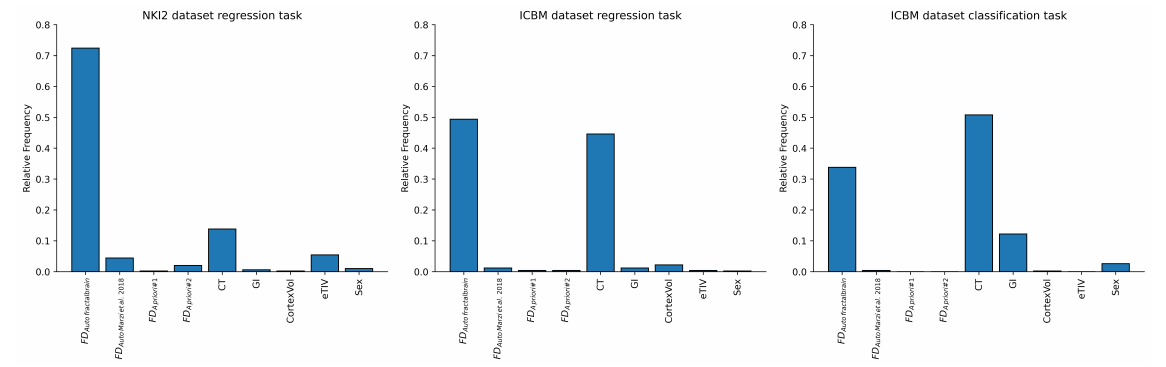
Figure 6. Relative frequency of neuroimaging features. For each regression/classification task, the frequency with which each feature was identified as the most important (highest impact as measured by the absolute value of the SHAP value over all the given samples across all outer CV test folds in 100 repetitions) is shown.